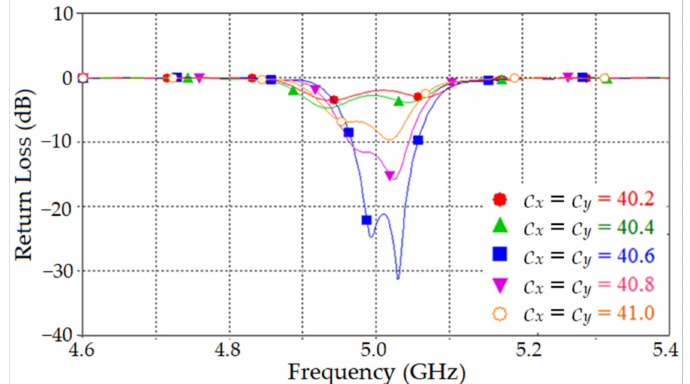
Figure 7. Simulated return loss for different values of ‘ c x ’ and ‘ c y